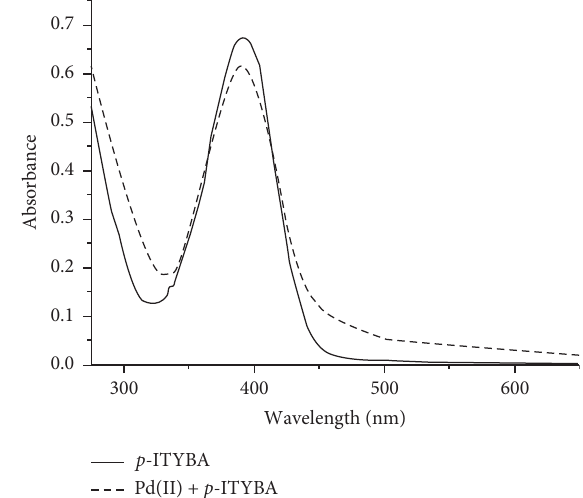
p -ITYBA Figure 2: Absorbance spectra of the p -ITYBA and Pd(II)- p - ITYBA complex (C p -ITYBA � 5.0 × 10 − 5 mol · L − 1 ;C R d( __ ) � 2.50 × 10 − 5 mol · L − 1 ; C N a Cl � 0.10 mol · L − 1 ; C UBS � 0.020 mol · L − 1 ; rO � 7.0; l � 1.0 cm).